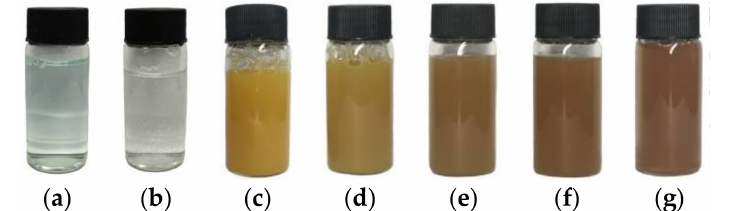
Figure 1. Photographs showing the solution color changes during the course of the as-synthesized samples’ formation process. ( a ) After mixing CuSO 4 · 5H 2 O and cetyltrimethylammonium bromide (CTAB); ( b ) immediately after ascorbic acid was added; ( c ) 0 min; ( d ) 5 min; ( e ) 20 min; ( f ) 40 min and ( g ) 60 min after adding